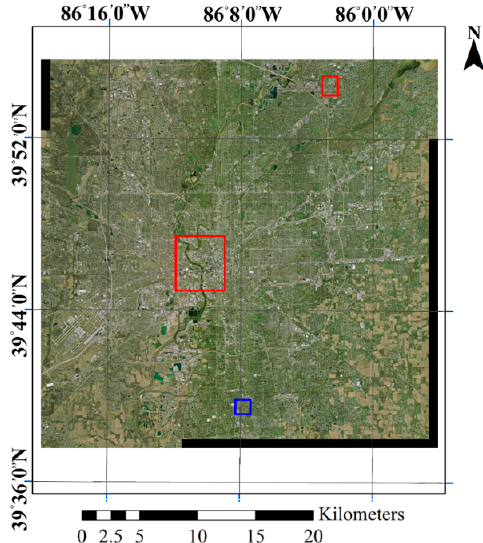
Figure 2. The same as Figure 1 but showing the training and validation data for the Marion dataset.